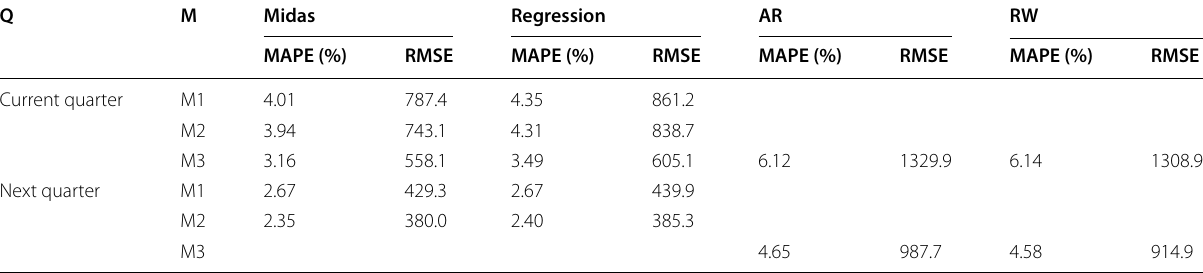
Table 11 MAPE and RMSE loss functions for the import of goods models (in nominal values) Q M